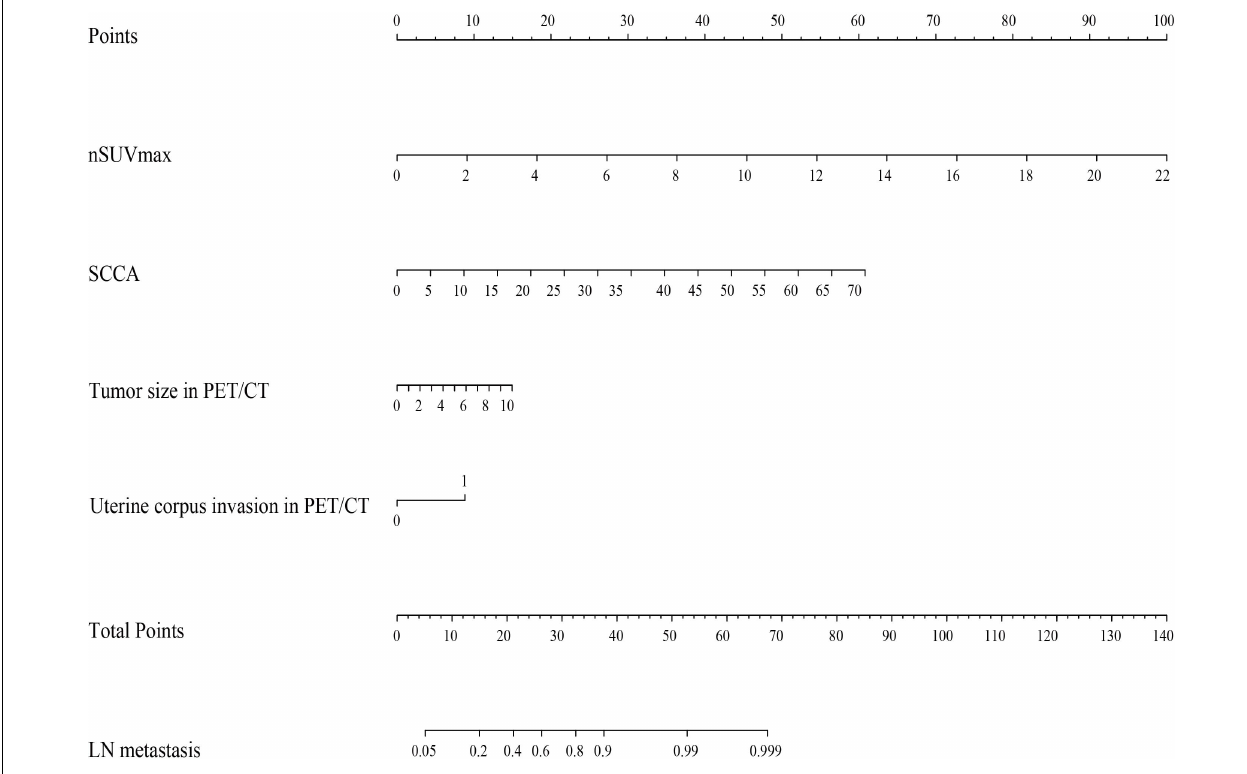
FIGURE 1 | A nomogram predicting the risk of lymph node metastasis in early-stage cervical cancer patients. nSUVmax, maximum standardized uptake value of lymph node; SCCA, squamous cell carcinoma associated antigen; PET/CT, positron emission tomography/computed tomography; LN, lymph